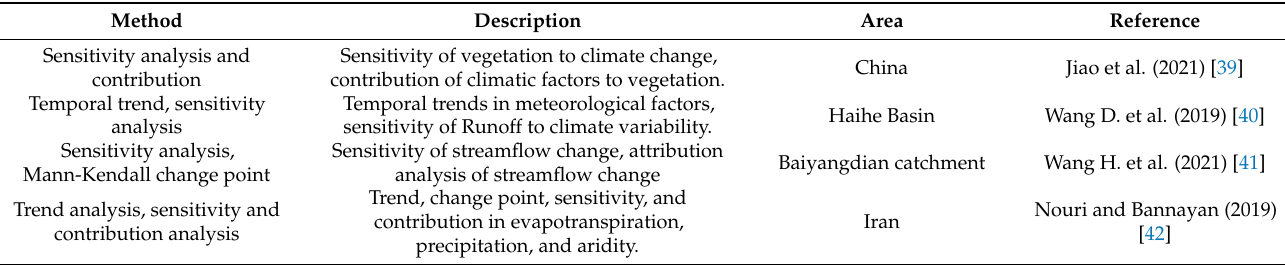
Table 6. Comparison of different works use similar